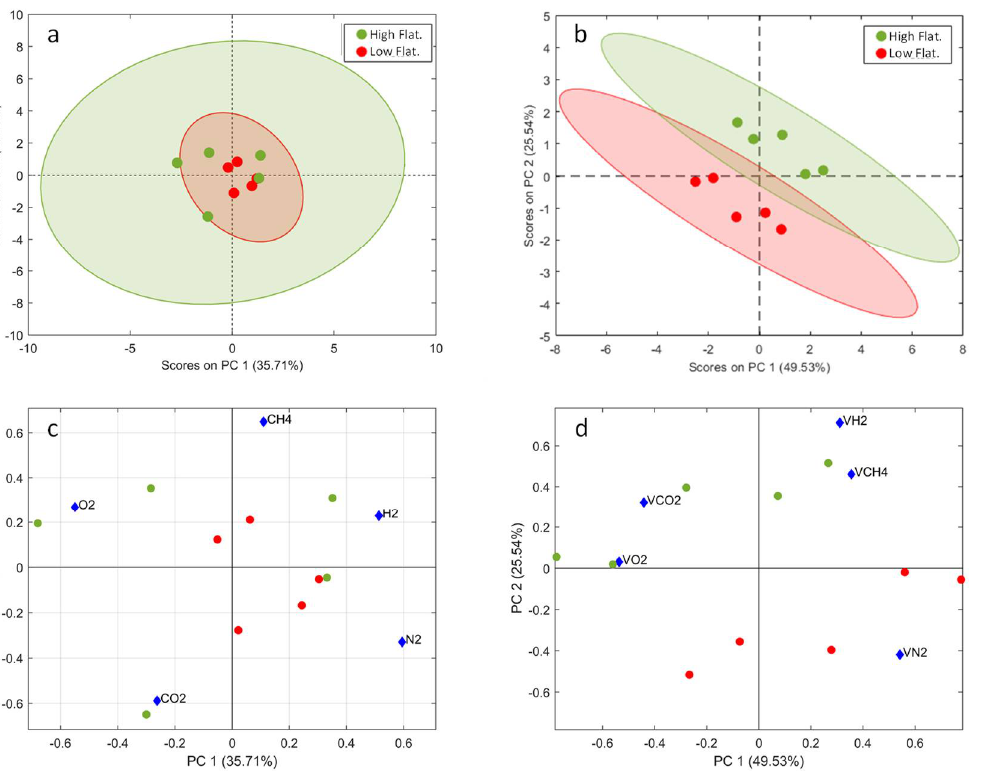
Table 4. Confusion matrix built on the multilevel PCA analysis.